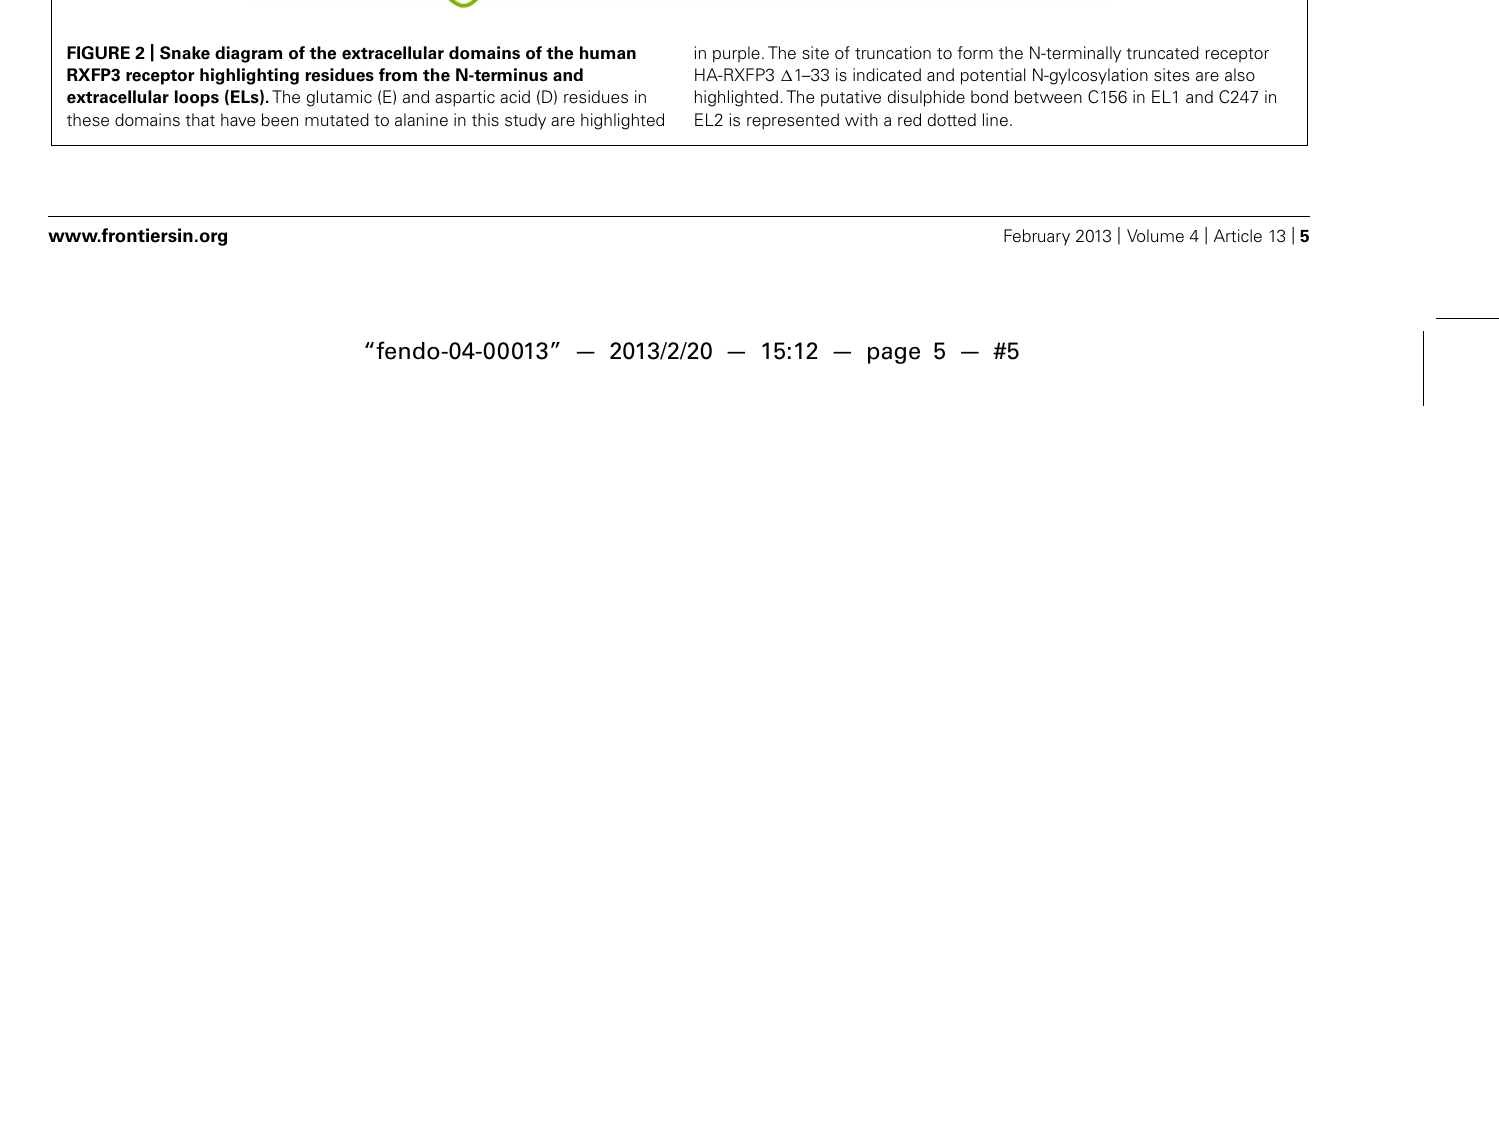
in purple.The site of truncation to form the N-terminally truncated receptor HA-RXFP3 Δ 1–33 is indicated and potential N-gylcosylation sites are also highlighted.The putative disulphide bond between C156 in EL1 and C247 in EL2 is represented with a red dotted